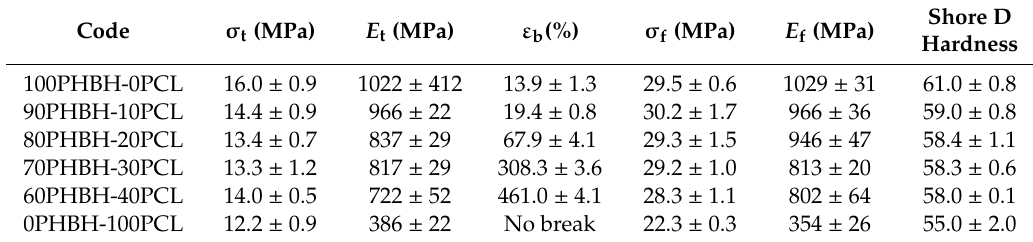
Table 5. Summary of the mechanical properties from tensile, flexural, and hardness tests of neat PHBH and PCL and PHBH / PCL blends with di ff erent PCL wt %. σ t and σ f represent the tensile and flexural strength, respectively. E t and E f are the respective values for the tensile and flexural modulus.